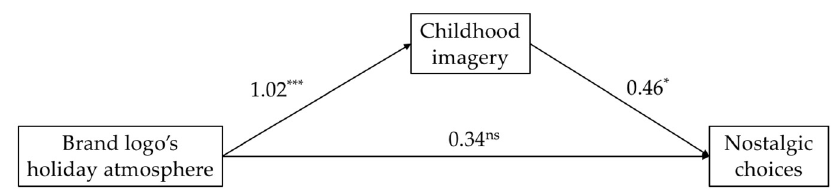
Figure 4. Childhood imagery as mediator.